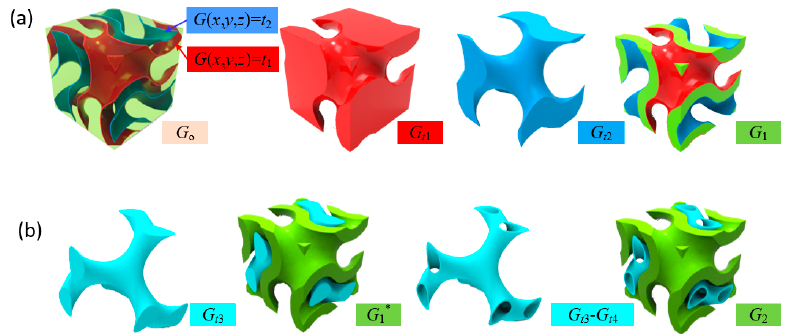
Figure 1. ( a ) Generation of TPMS-based sheet structure; and ( b ) generation of multi-sheet structure.